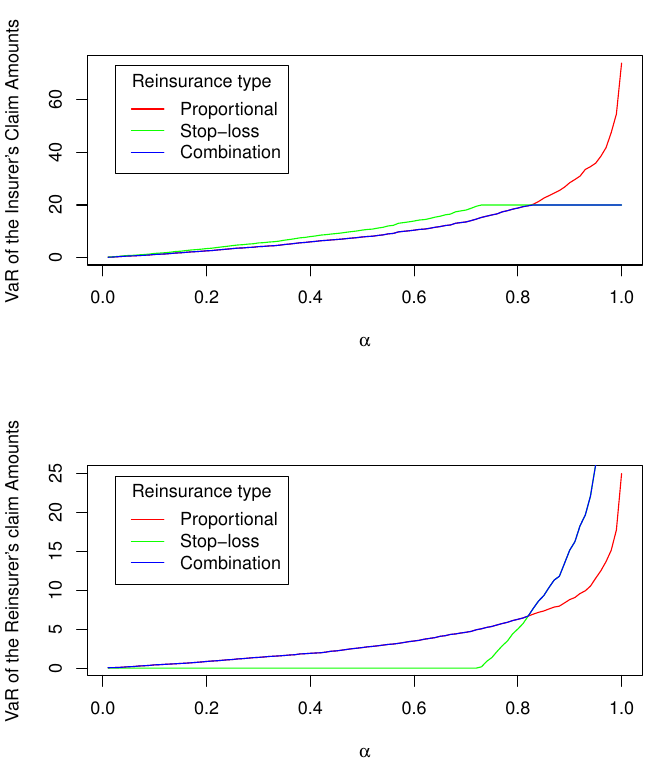
Figure 2. Graphical representation of the insurer’s claim amount and the reinsurer’s claim amount measured using VaR at the α confidence level under proportional reinsurance with c = 75% (the red curve), stop-loss reinsurance with d = 20 (the green curve), and a combination of proportional and stop-loss reinsurance with c = 75% and d = 20 (the blue curve) when the initial claim amount X follows an exponential distribution ( λ =